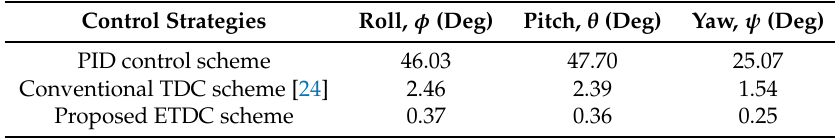
Table 2. RMS values of trajectory-tracking errors (Figure 5b) measured from 5 s to 10